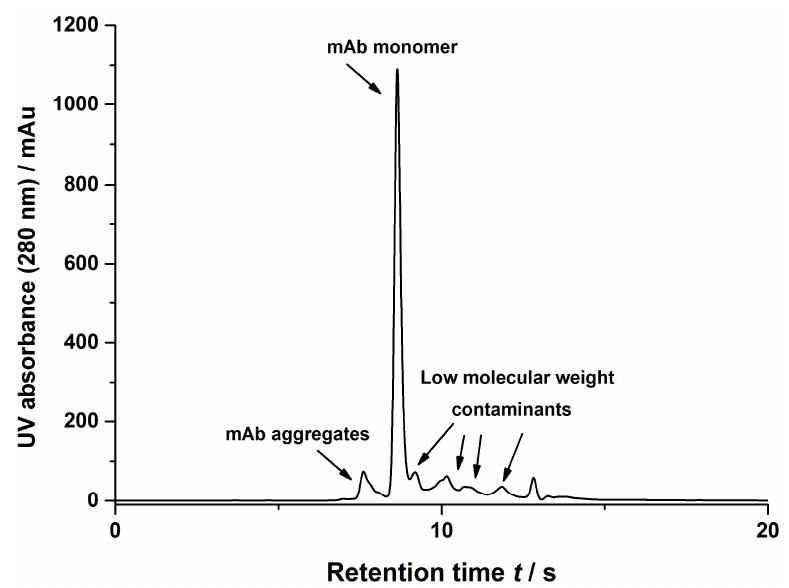
Figure 7. ( a ) Binding isotherms determined for purified mAb1; ( b ) Exponential regression of the equilibrium binding constant dependence on the NaCl concentration; ( c ) Linear regression of the maximum adsorbens capacity dependence on the NaCl concentration. Buffer: 10 mM KPi, pH = 6, various NaCl concentrations.